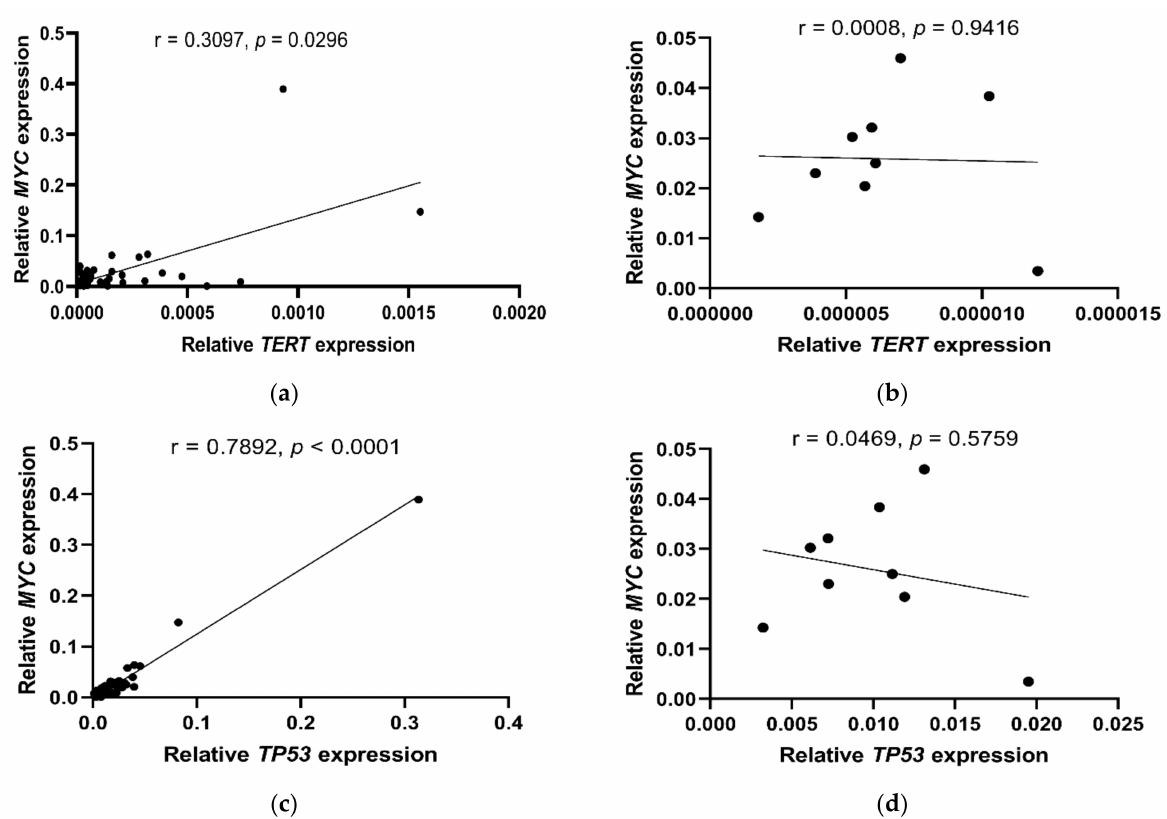
Figure 3. Relationships between the expression of TERT , MYC and TP53 genes observed in the blood of BC patients ( a , c ) and BC organoids ( b , d ). Statistical analysis was performed using the Spearman r correlation test ( a , c ) and the Pearson correlation (PC) test ( b , d